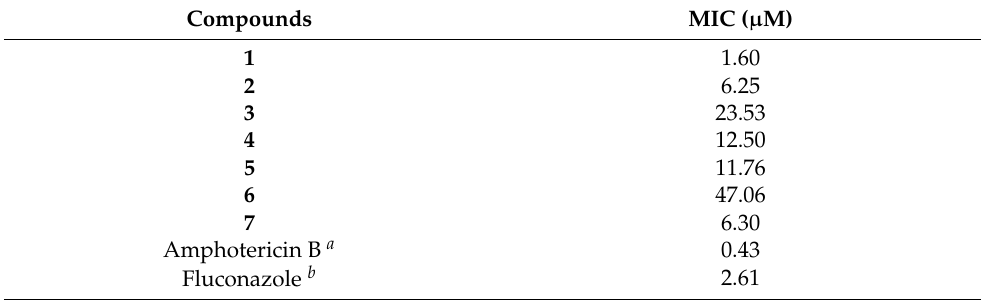
Table 4. The inhibitory e ff ects of compounds 1 – 7 on NO production in LPS-stimulated RAW264.7.